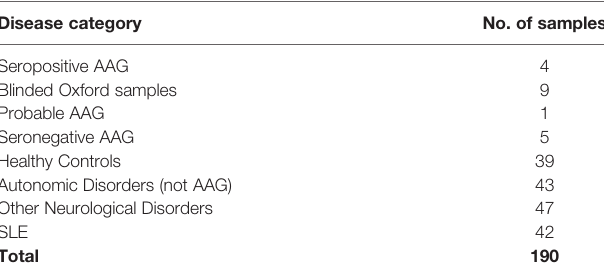
TABLE 1 | Clinical diagnoses of samples tested for gnACHR immunomodulation. Disease category No. of samples